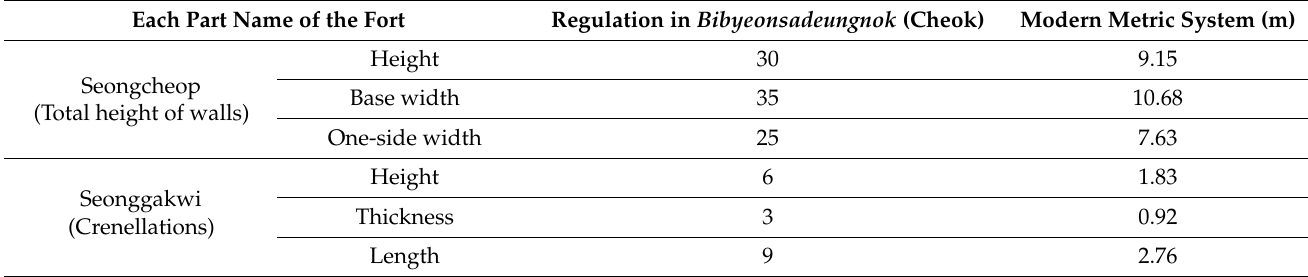
Table 3. Modern unit conversion of measurement regulations issued in Bibyeonsadeungnok